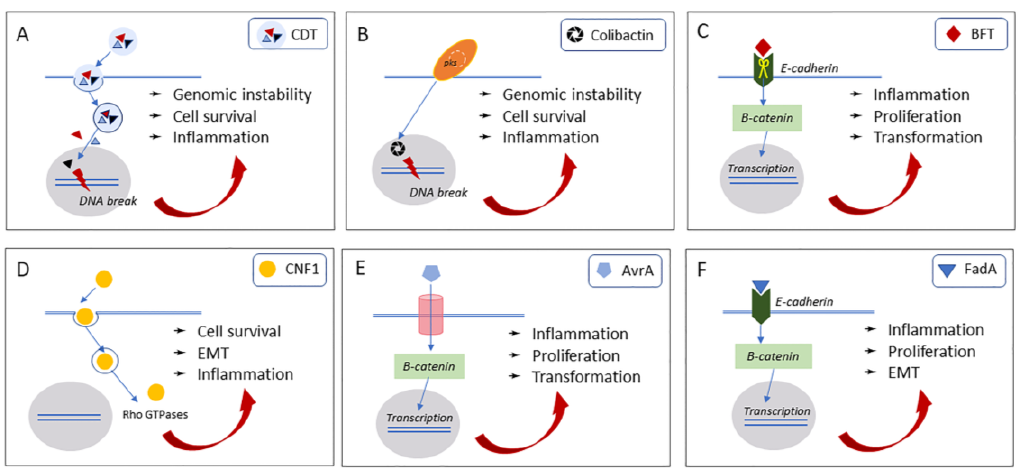
Figure 3. Toxic mechanisms by which virulence factors may contribute to CRC. Schematic representation of the toxic mechanism of each virulence factor described in this review. ( A , B ) represent Cdt and colibactin, respectively, whose mode of action contribute to CRC development or progression through genomic instability. ( C – F ) represent virulence factors that contribute to CRC through alteration of crucial cell signaling pathways involved in cell proliferation and cell death. It is worth noting that inflammation is somehow involved in the activity of all the herein described virulence factors. Thin blue arrows indicate the entry of the bacterial factors; thick red arrows indicate the CRC-related effects.